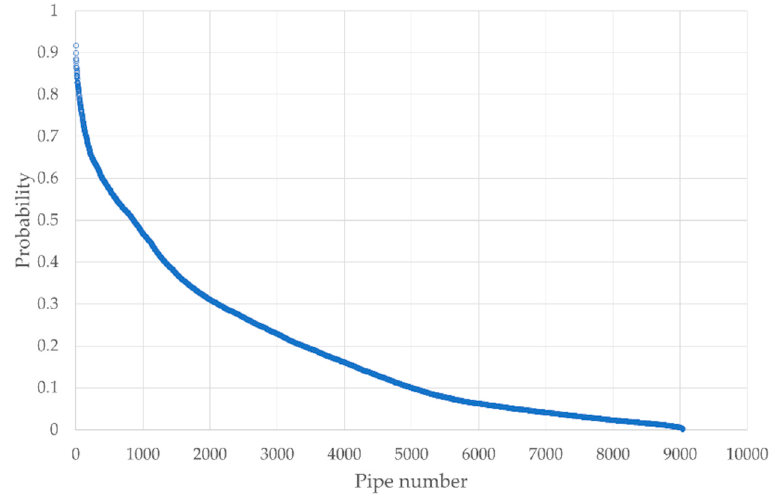
Figure A6. Plot of probability values from RF analysis sorted from highest to lowest values.